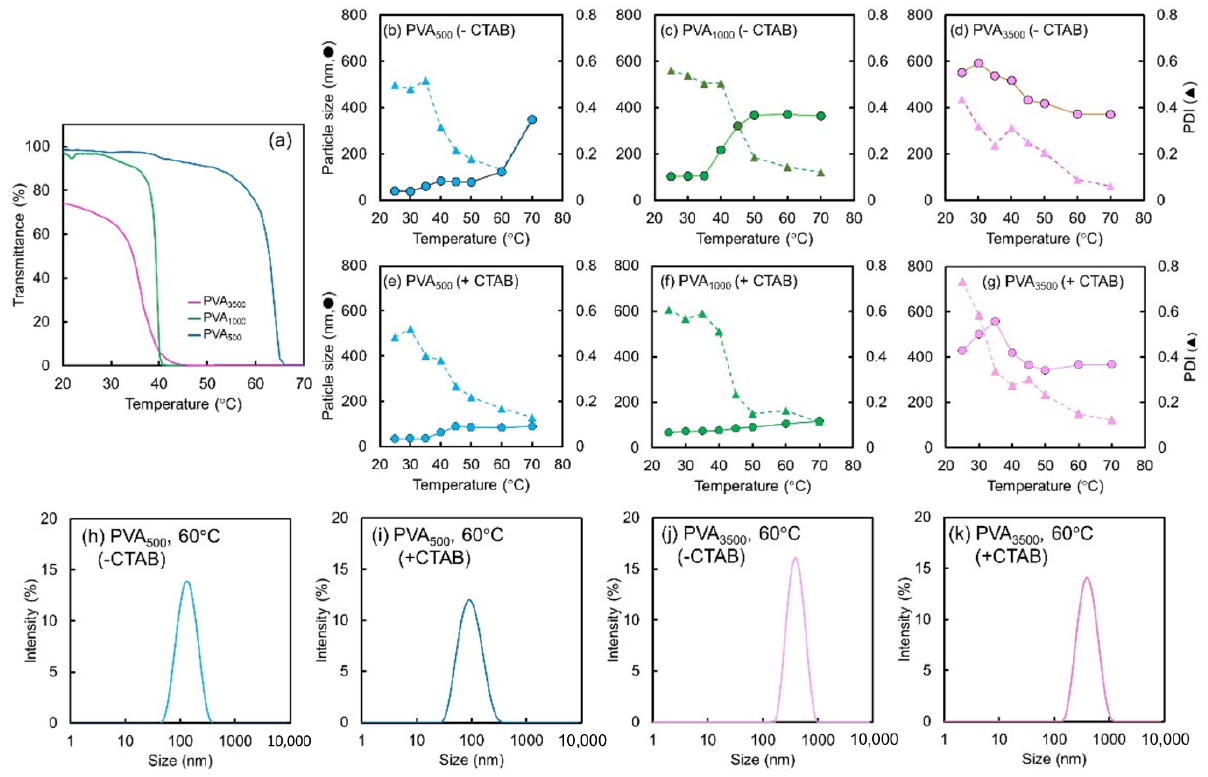
Figure 4. Transmittance of PG 500 , PG 1000 , and PG 3500 particle dispersions prepared via dispersion polymerization ( a ). Average particle sizes (circles) and PDI (triangles) of PG 500 ( b , e ), PG 1000 ( c , f ), and PG 3500 ( d , g ) particles at various temperatures without ( b – d ) or with ( e – g ) CTAB. Particle size distributions of PG 500 ( h , i ) and PG 3500 ( j , k ) particles at 60 ◦ C without ( h , j ) and with ( i , k ) CTAB. Polymer gel particles were prepared via dispersion polymerization with PVA polymer chains of different lengths (polymerization degrees: 500, 1000, and 3500) at 70 ◦ C for 3